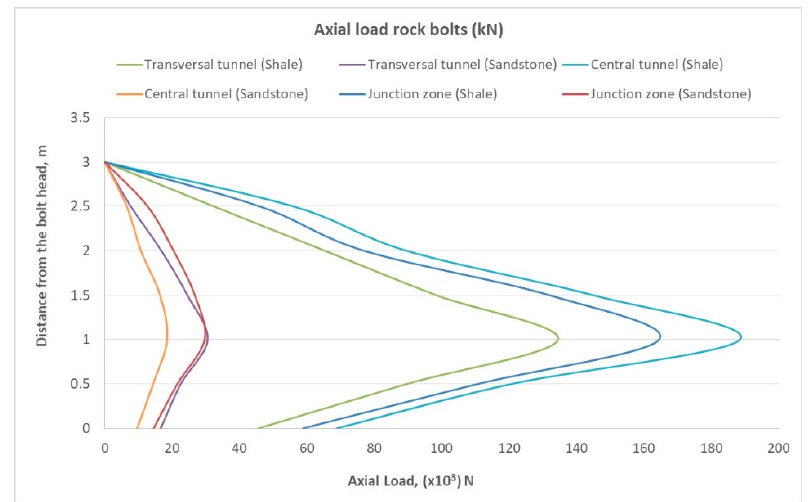
Figure 9. Axial load in rock bolts. Shale and sandstone rock masses.